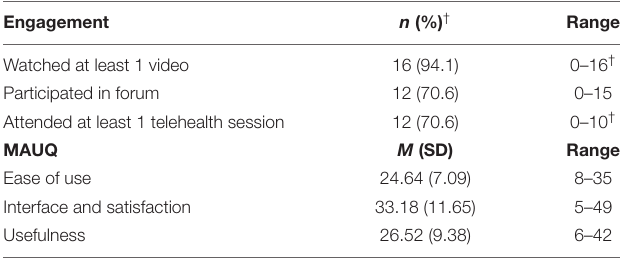
TABLE 2 | Engagement and satisfaction measures for the BEAM App program. TABLE 3 | Sample characteristics at